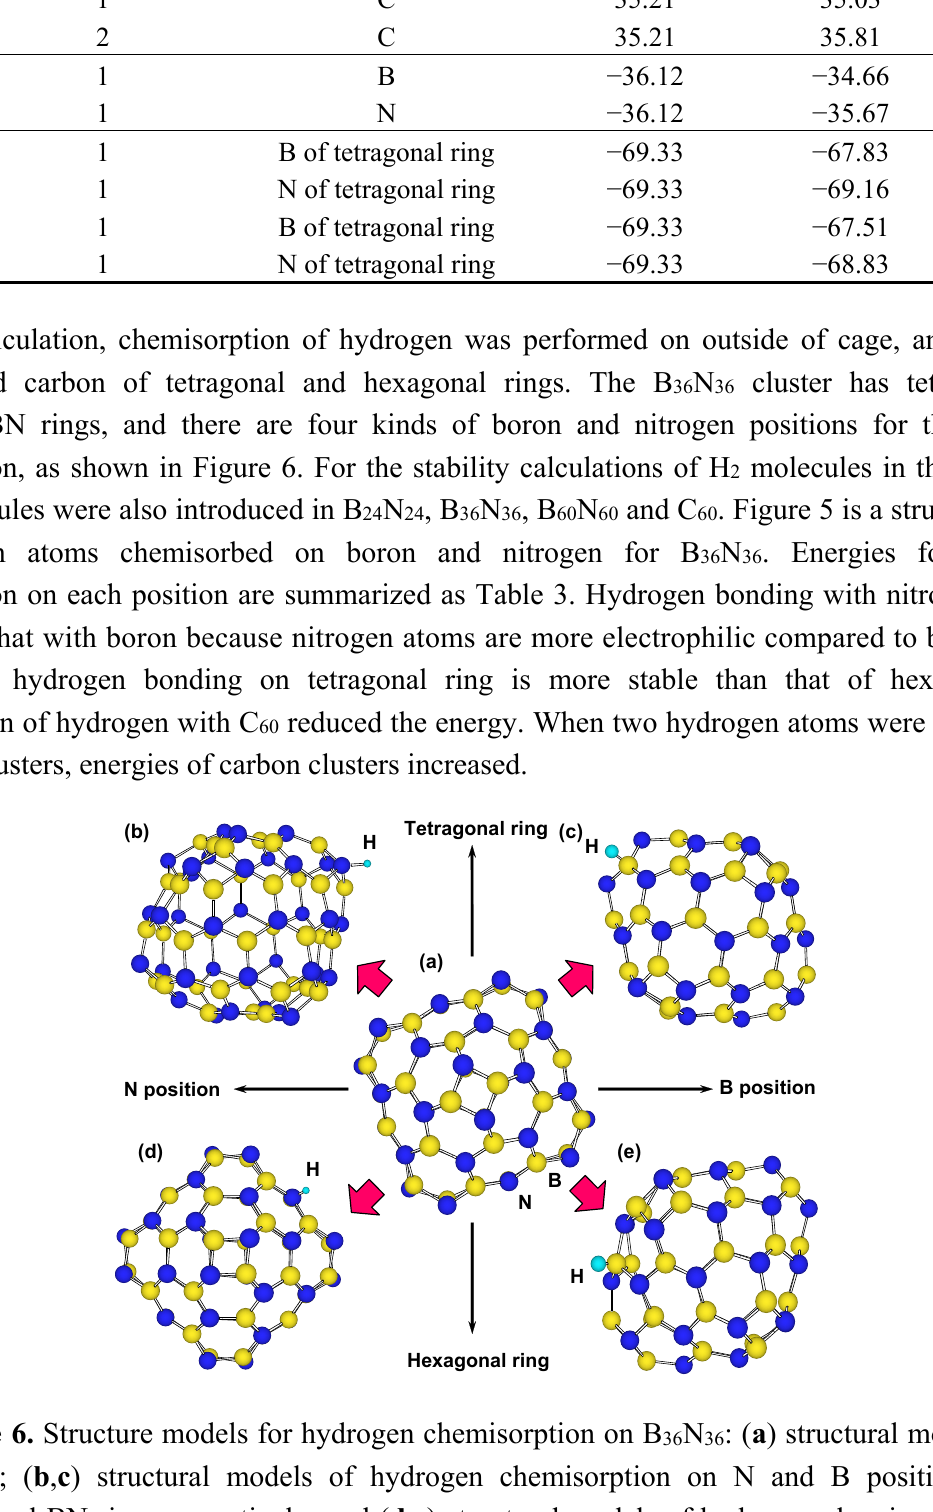
Figure 6. Structure models for hydrogen chemisorption on B 36 N 36 : ( a ) structural model of B 36 N 36 ; ( b , c ) structural models of hydrogen chemisorption on N and B positions of tetragonal BN ring, respectively; and ( d , e ) structural models of hydrogen chemisorbed on N and B positions of hexagonal BN ring, respectively.